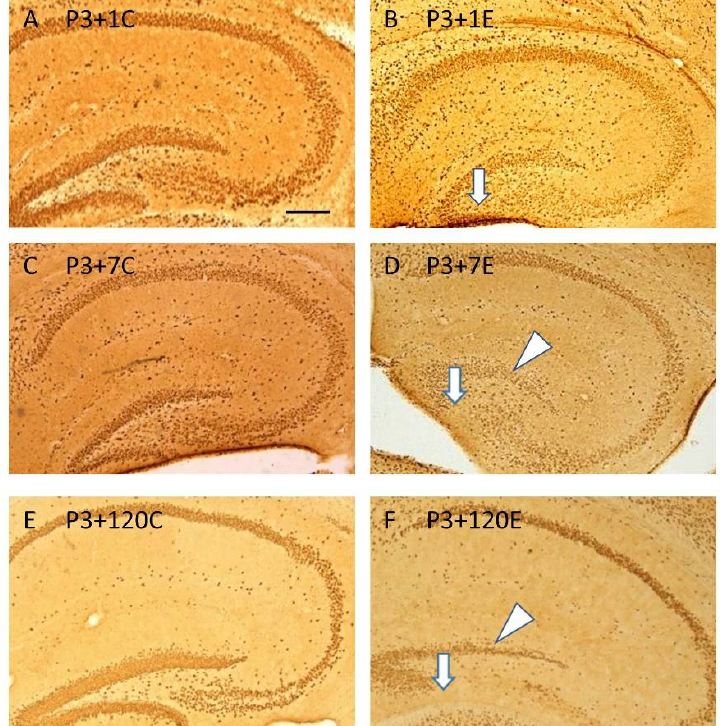
Figure 2. NeuN immunostaining shows that γ-irradiation with 5Gy at postnatal day 3 induced hypoplasia of the infrapyramidal blade of the stratum granulosum of the dentate gyrus (arrows) at 1 (( B ) compared to ( A ) in the control), 7 (( D ) compared to ( C ) in the control), and 120 (( F ) compared to € in the control) days after radiation exposure. Loss of NeuN immunopositive neurons also occurred in the suprapyramidal blade of the stratum granulosum of the dentate gyrus, particularly at 7 (arrowhead in ( D )) and 120 (arrowhead in ( D )) days after irradiation when compared to the age-matched control mice ( C , E ) ( n = 5). Scale bar = 200 µ m in A applies to ( B – F ). Ki67 immunohistochemistry indicated a significant reduction in Ki67 immunopositive cells in the hilus, including the subgranular zone of the dentate gyrus, which started at 1 day (Figure 3A–D,I) after irradiation of P3 mice, and persisted from 7 days (Figure 3E,F,I) to 120 days (Figure 3G and H, I) after irradiation exposure. Counterstaining with hematoxyin showed many apoptotic bodies in the hilus (including the subgranular zone) of the dentate gyrus at 1 day after irradiation (Figure 3D). At 120 days after irradiation, dentate gyrus (Figure